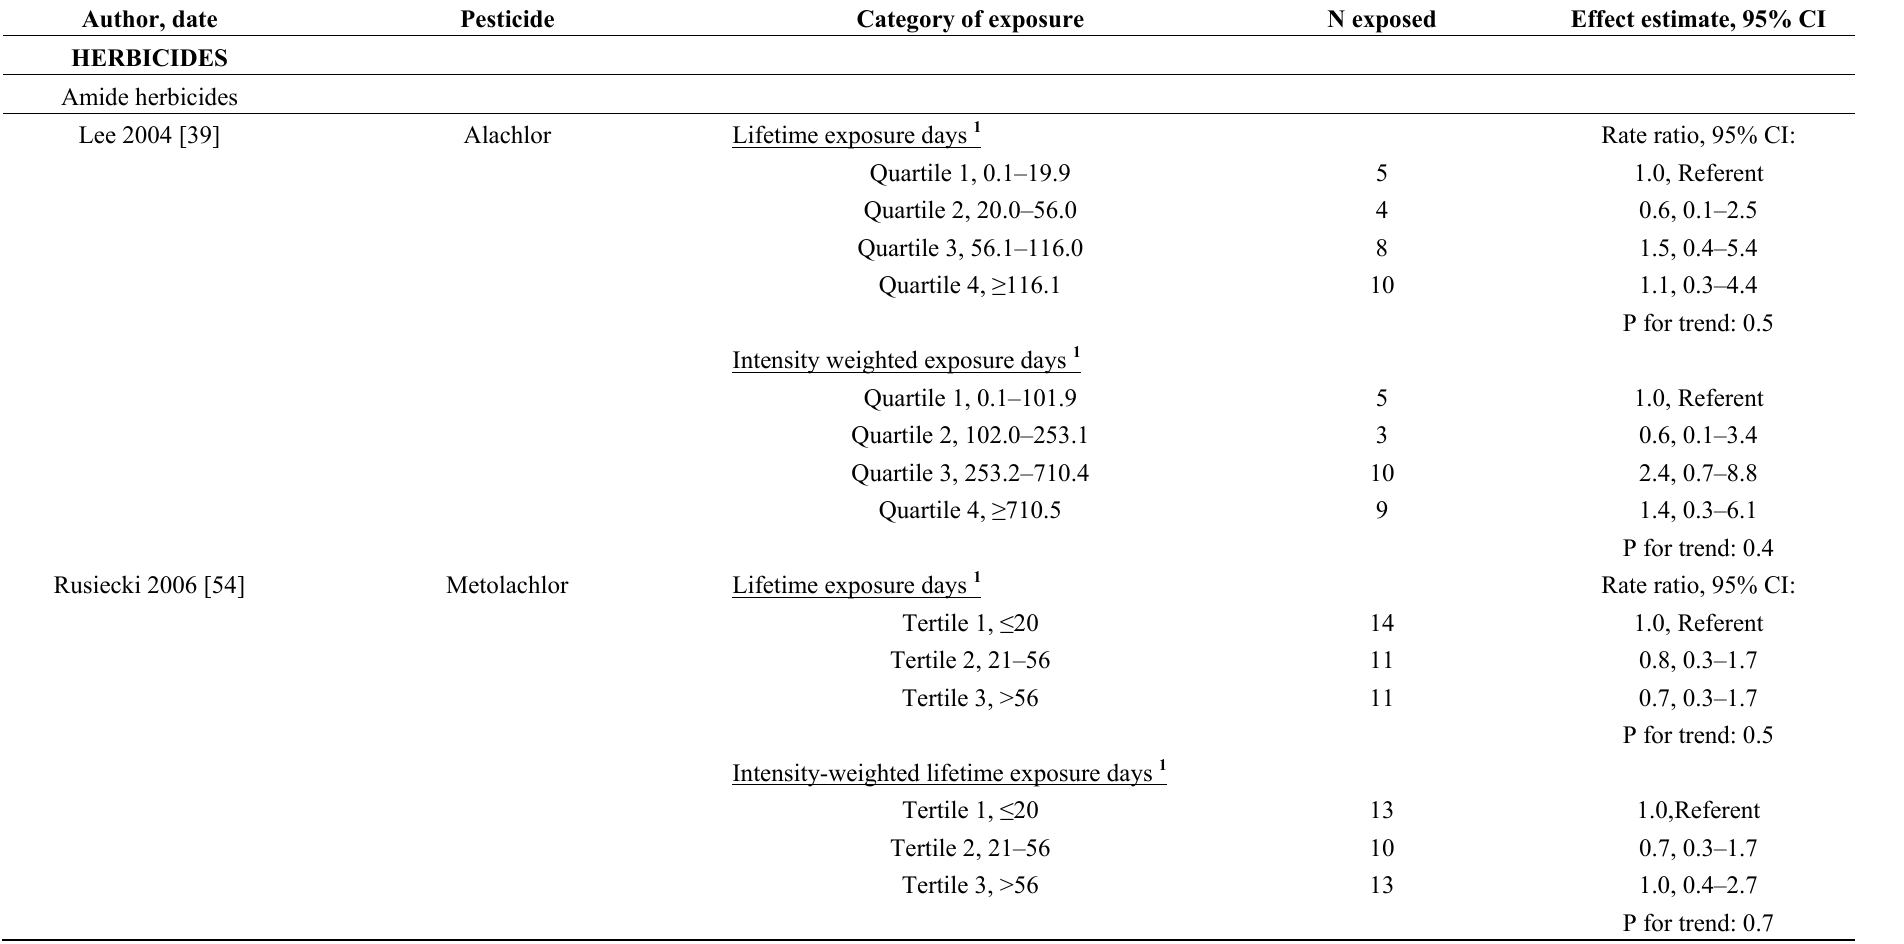
Table 2. Effect estimates from studies that investigated associations between non-Hodgkin lymphoma and herbicides, insecticide, and fungicide exposures classified using multiple